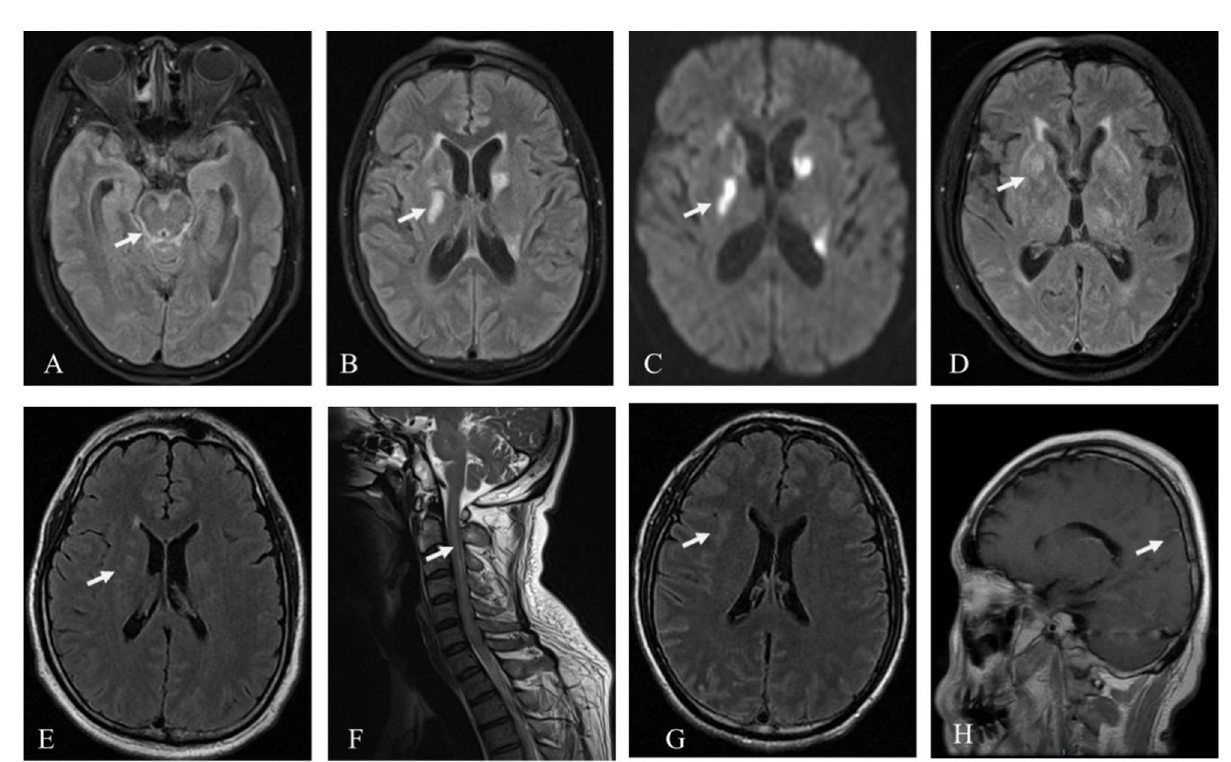
FIGURE1 Patient MRI images. Hyperintensity signal inthe brainstem, pia mater, and basal ganglia on T2 FLAIR (A, B) and the basal ganglia on DWI in the patient in Case 2 (C) ; hyperintensity signal in the basal ganglia on T2 FLAIR in Case 3 (D) ; hyperintensity signal in the periventricular white matter on T2 FLAIR (E) , and the cervical spinal cord on T2 in the patient in Case 4 (F) ; hyperintensity signal in the subcortex on T2 FLAIR and parieto-occipital sulci meningeal enhancement on T1 in the patient in Case 5 (G, H)